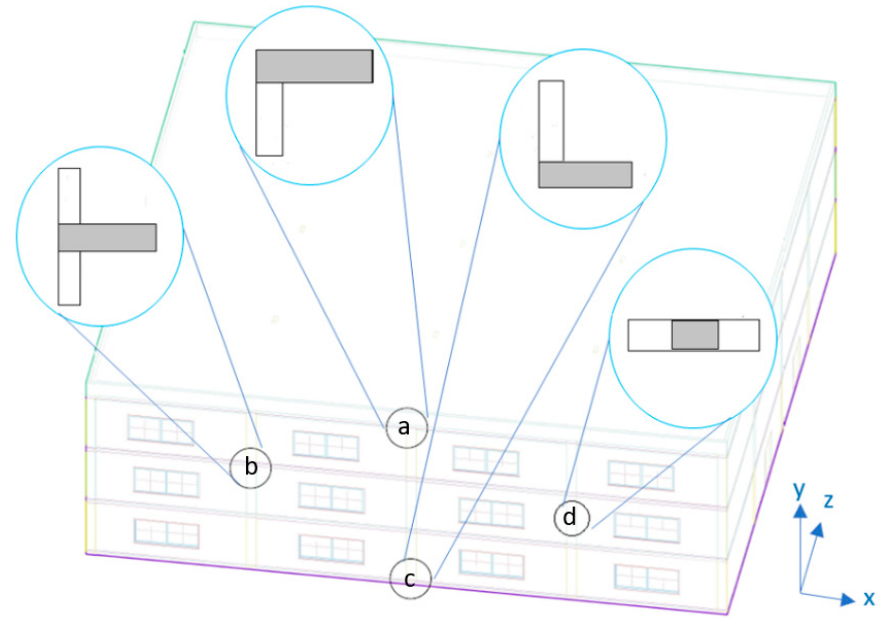
Figure 1. Location of the thermal bridges and the typical layout: (a) roof, (b) intermediate floor slab, (c) slab-on-grade, and (d) concrete column.